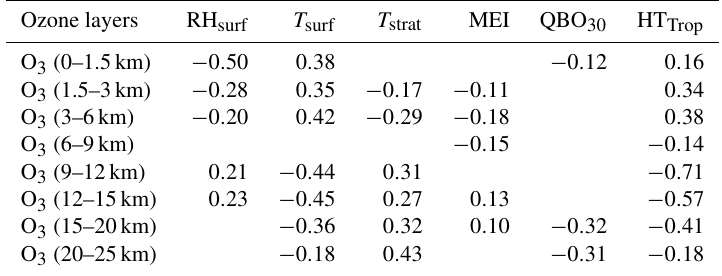
Table 3. Correlation coefficients between O 3 anomalies and climate/meteorological variables at each layer. Ozone layers RH surf T surf T strat